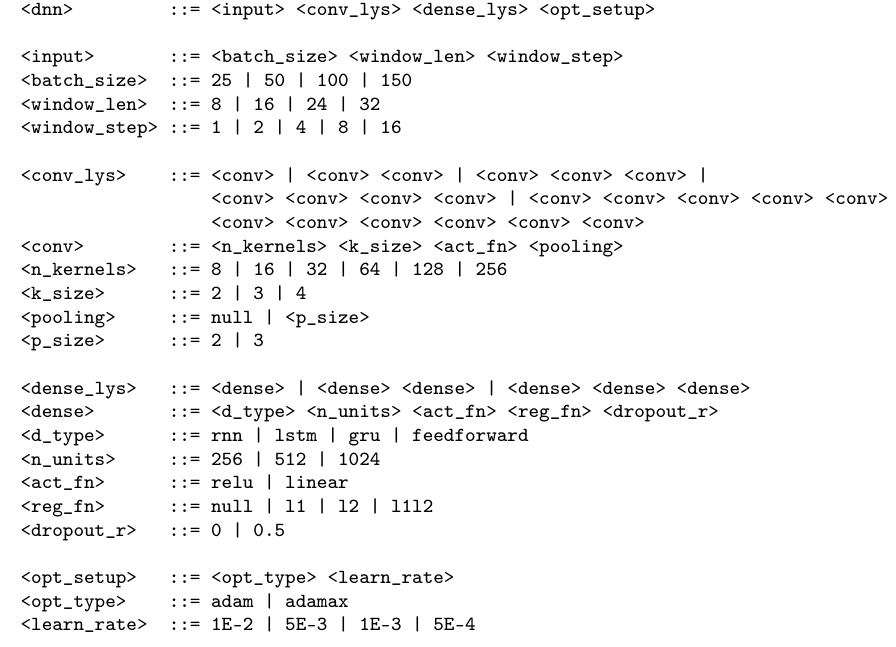
Figure 3. Definition of the grammar in Backus–Naur Form for the OPPORTUNITY dataset.